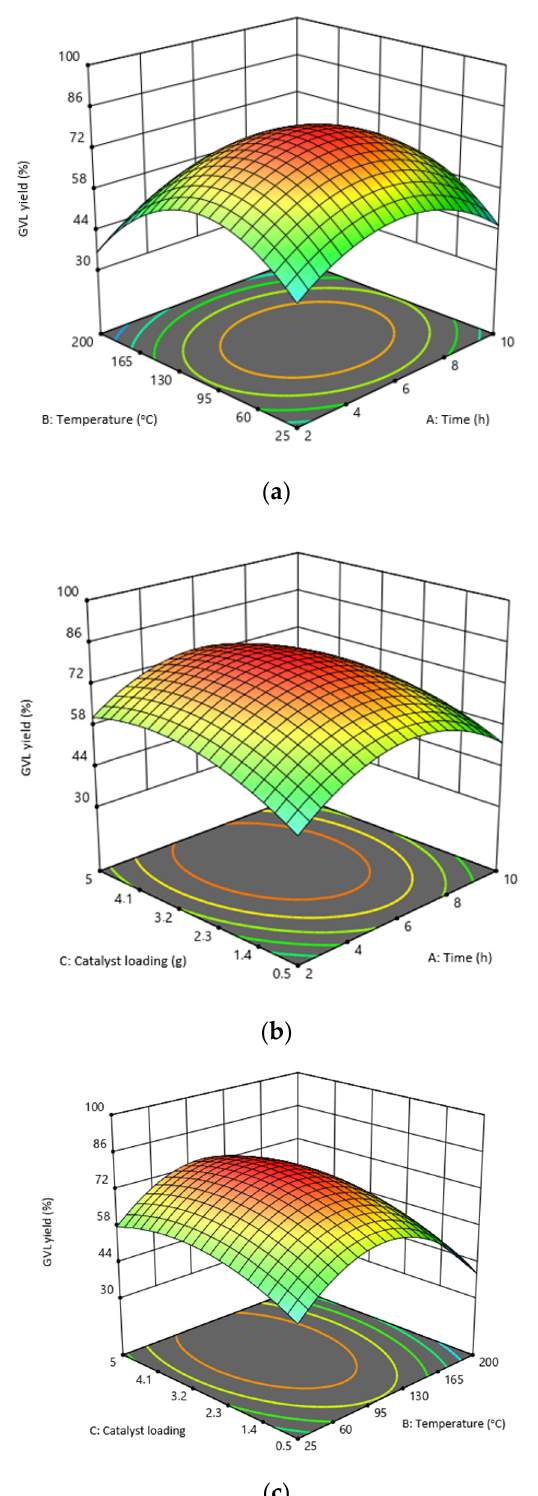
Figure 4. Response surface and contour plots for the interaction of the investigated factors: ( a ) temperature vs. time; ( b ) catalyst loading vs. time; ( c ) catalyst loading vs. temperature. Singh et al. [35] used Ni/NiO catalyst to produce GVL from commercial LA which showed high conversion of >90% and high selectivity of >90%; the LA conversion obtained in this study is higher by 7%, whereas the GVL selectivity is lower by 9% and the di ff er- ence is due to the di ff erent catalysts used. Córdova-Pérez et al. [36] synthesized GVL from